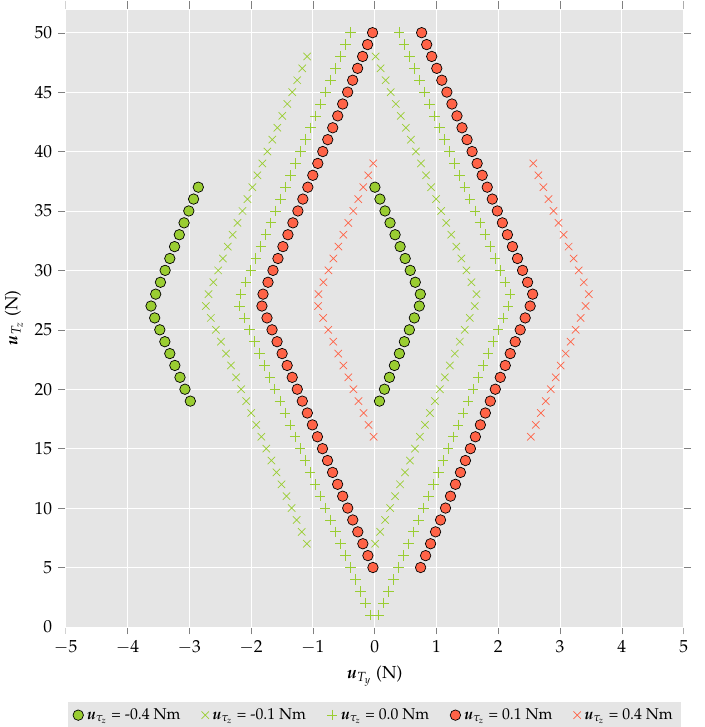
Figure 3. The maximum and minimum values of u T y that can be achieved given a set of u T z and u τ . Note that u τ x = u τ z = 0 (Nm).